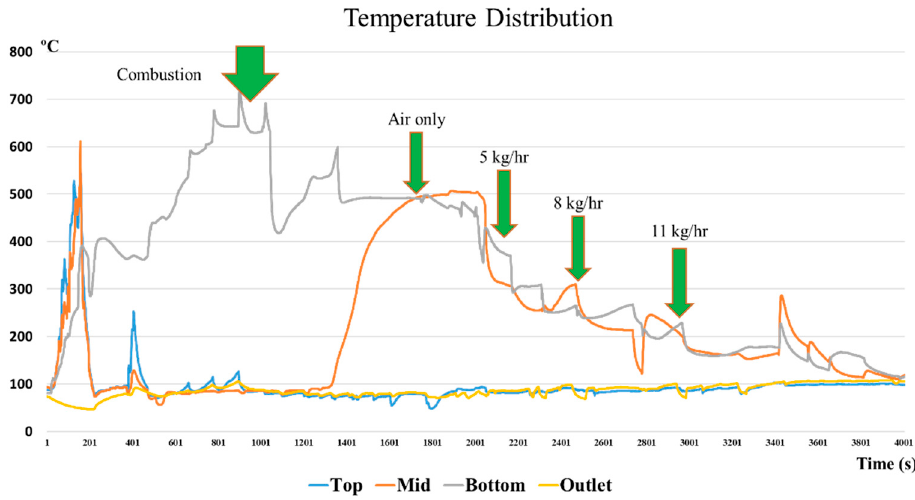
Figure 5. Temperature distribution of the top, middle, and bottom of the gasifier.